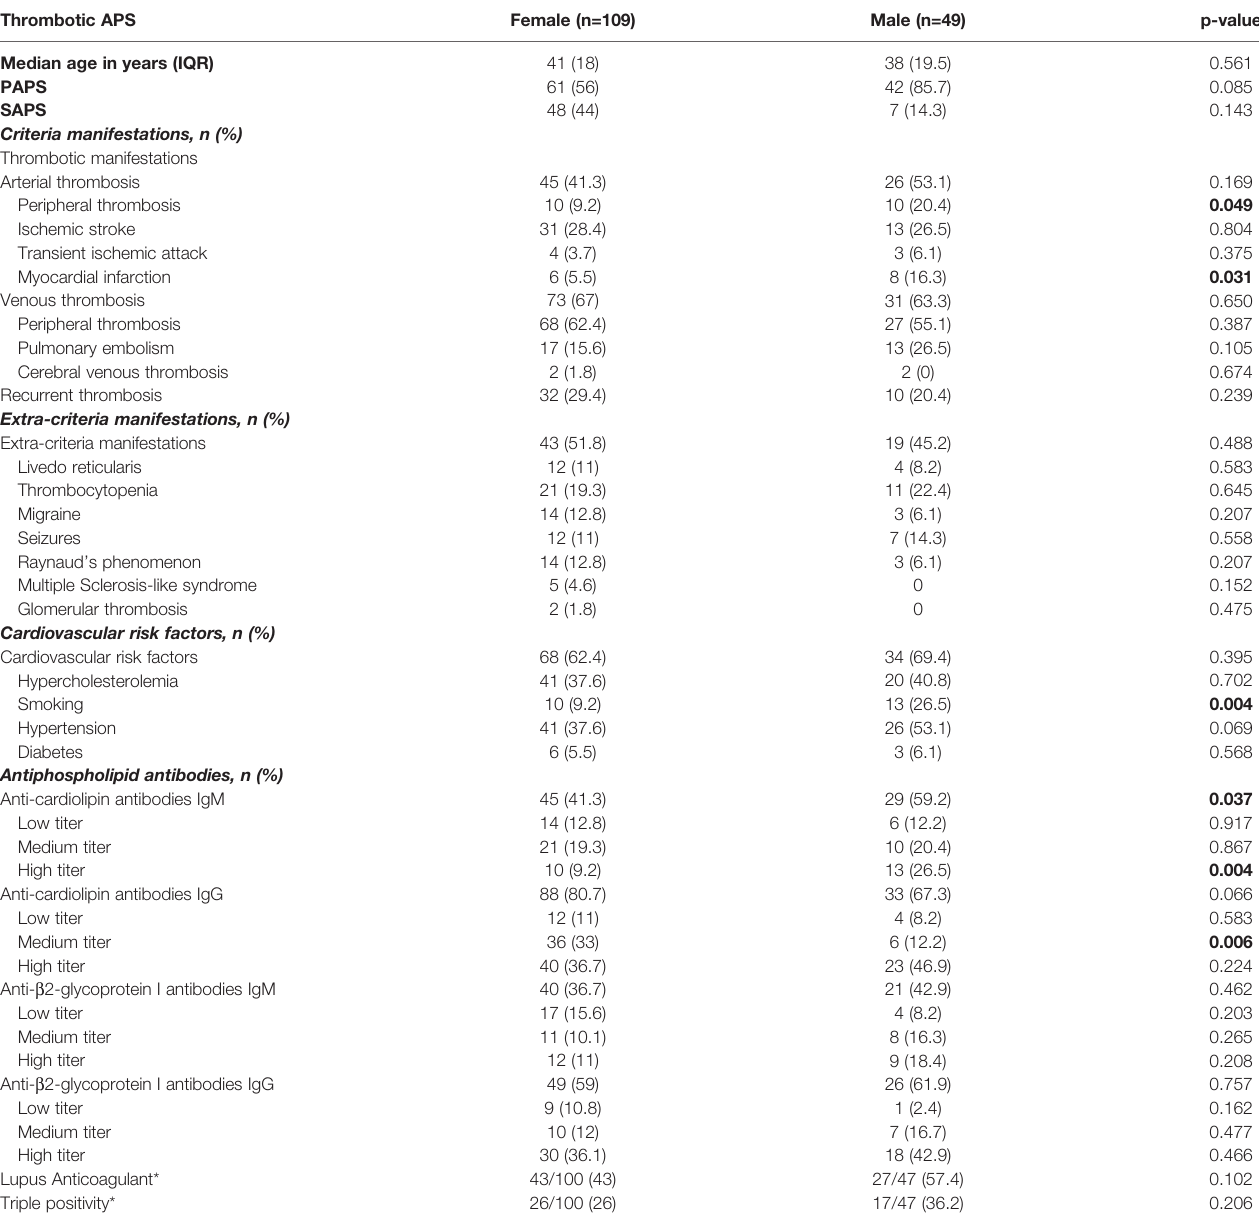
TABLE 2 | Difference between female and male patients with thrombotic